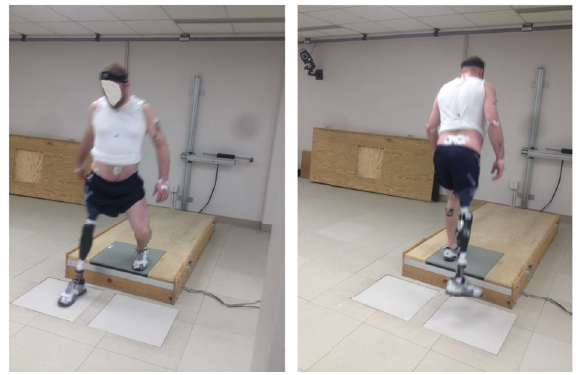
Figure 4: Data collection setup for the stepping trials: the left fi gure shows a stepping down trial, and the right fi gure shows a stepping up trial by a prosthesis user participant.